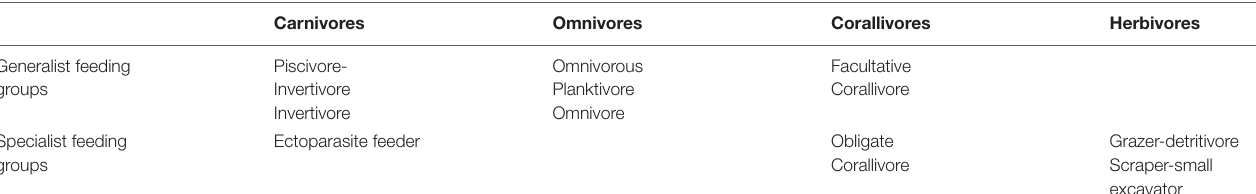
TABLE 1 | Feeding groups assigned to trophic level and as generalist or specialist